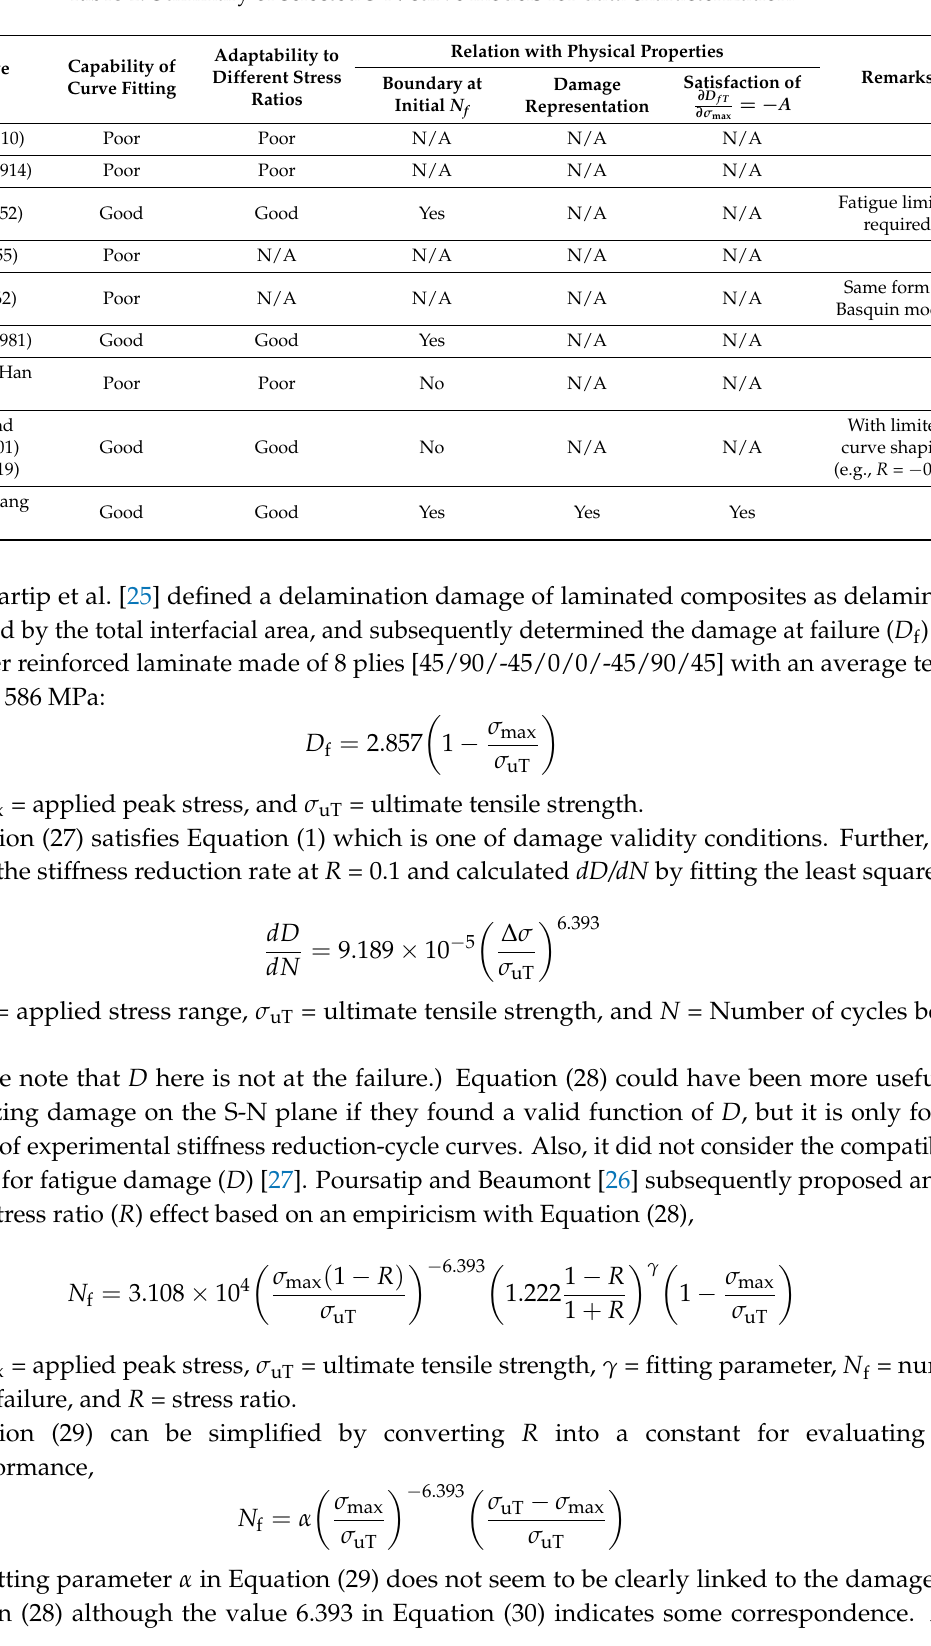
Table 1. Summary of selected S-N curve models for data